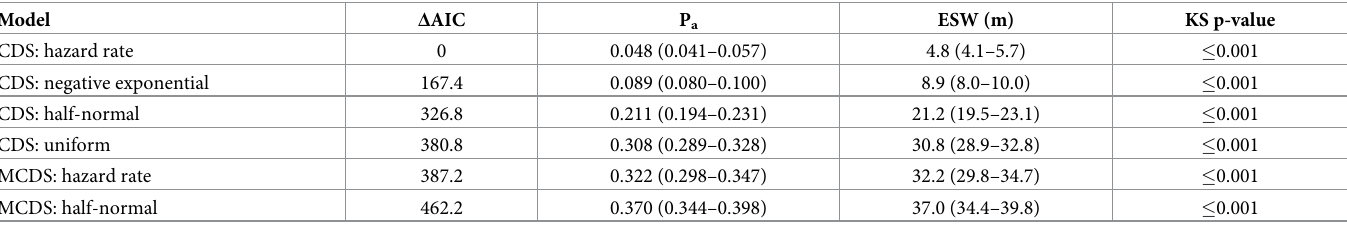
Table 1. Key parameters associated with six models to estimate detectability of olive baboons along road transects in Lake Manyara National Park (Tanzania).